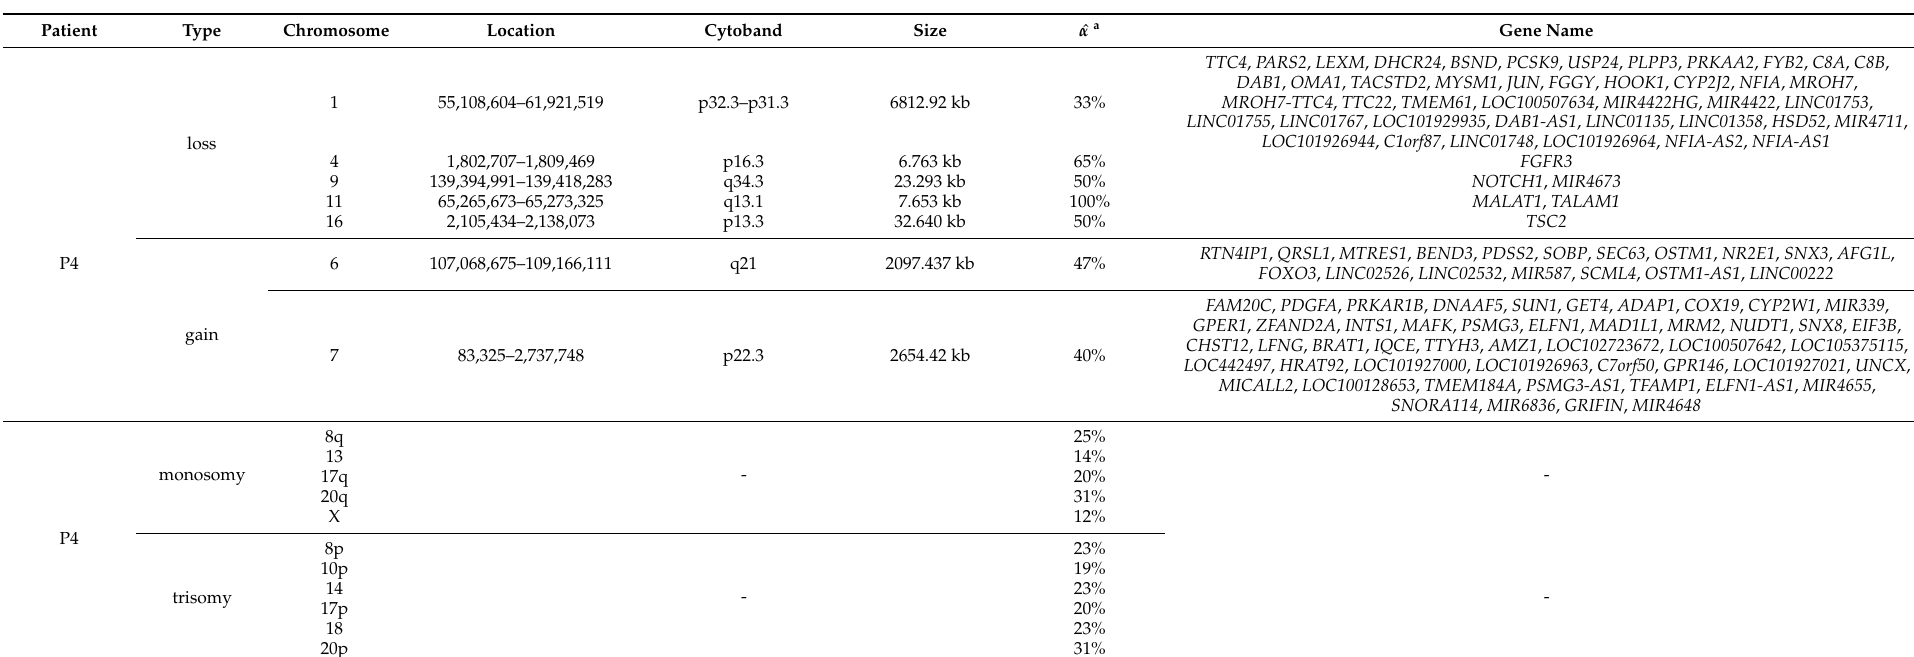
Table 3. List of aberrations found in P4, P5, and P16 (third